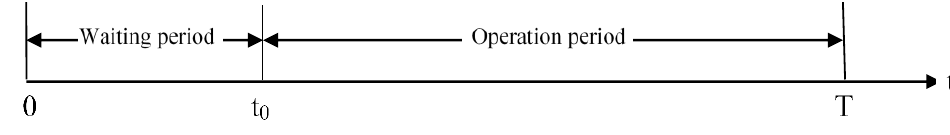
Figure 1. The timeline of Carbon capture, utilization, and storage (CCUS) technology investment.